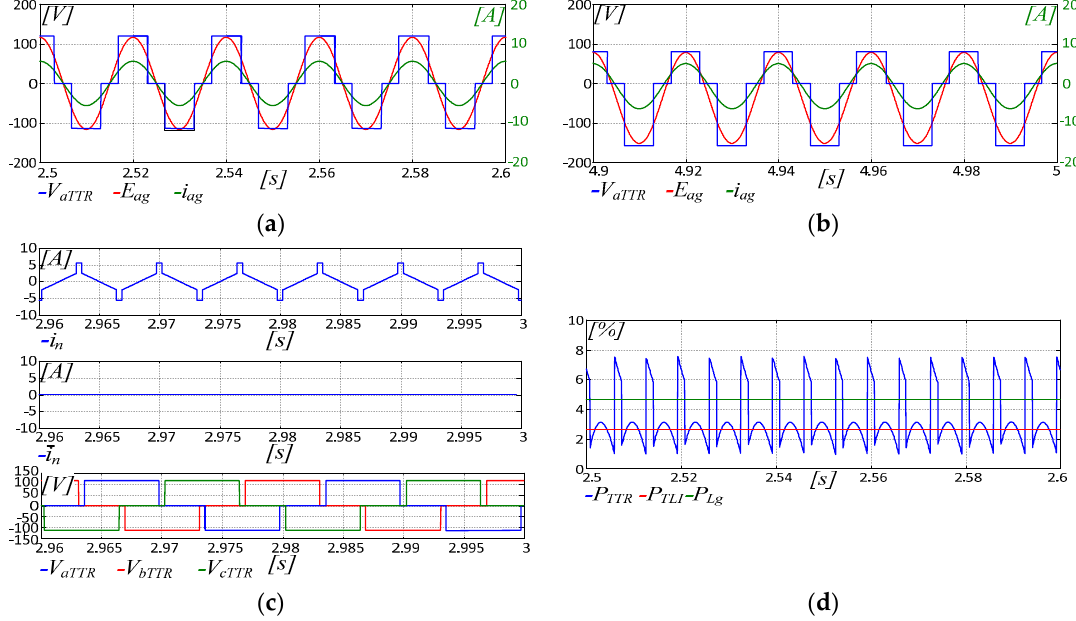
Figure 16. Averaged-value model. ( a ) Balanced DC bus capacitor voltage operations , V aTTR , E ag , and i ag . ( b ) Unbalanced DC bus capacitor voltage operations. ( c ) Current i n , average value 𝑖̅ 𝑛 , and AC input Vienna voltages V iTTR . ( d ) TRR power losses P TTR , TLI power losses P TLI , and PMSG power losses P Lg .